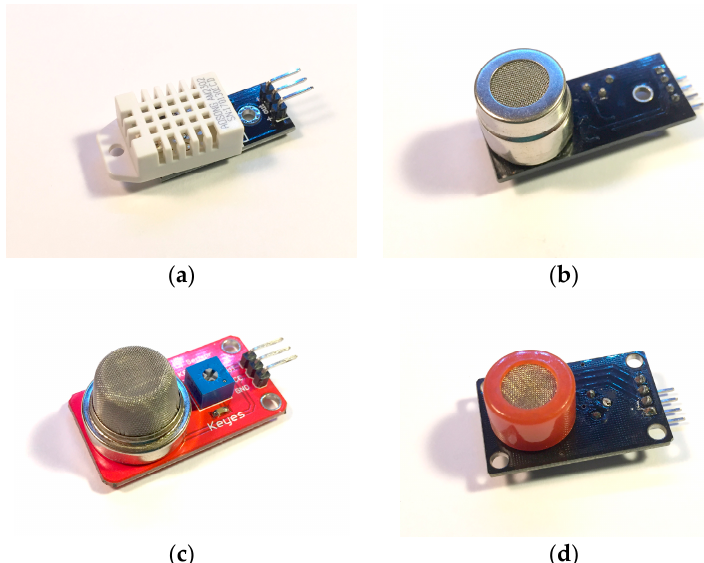
Figure 3. Low cost air quality sensors that make up the designed sensorization device: ( a ) the DHT22 sensor measures ambient temperature in addition to relative humidity of the air; ( b ) the purpose of the MG-811 sensor is to measure the concentration of carbon dioxide (CO 2 ) in the environment; ( c ) the MQ-2 sensor measures smoke in the environment and is also sensitive to liquefied petroleum gas, propane, methane, alcohol and hydrogen; ( d ) the MQ-7 sensor is responsible for measuring the concentration of carbon monoxide (CO).